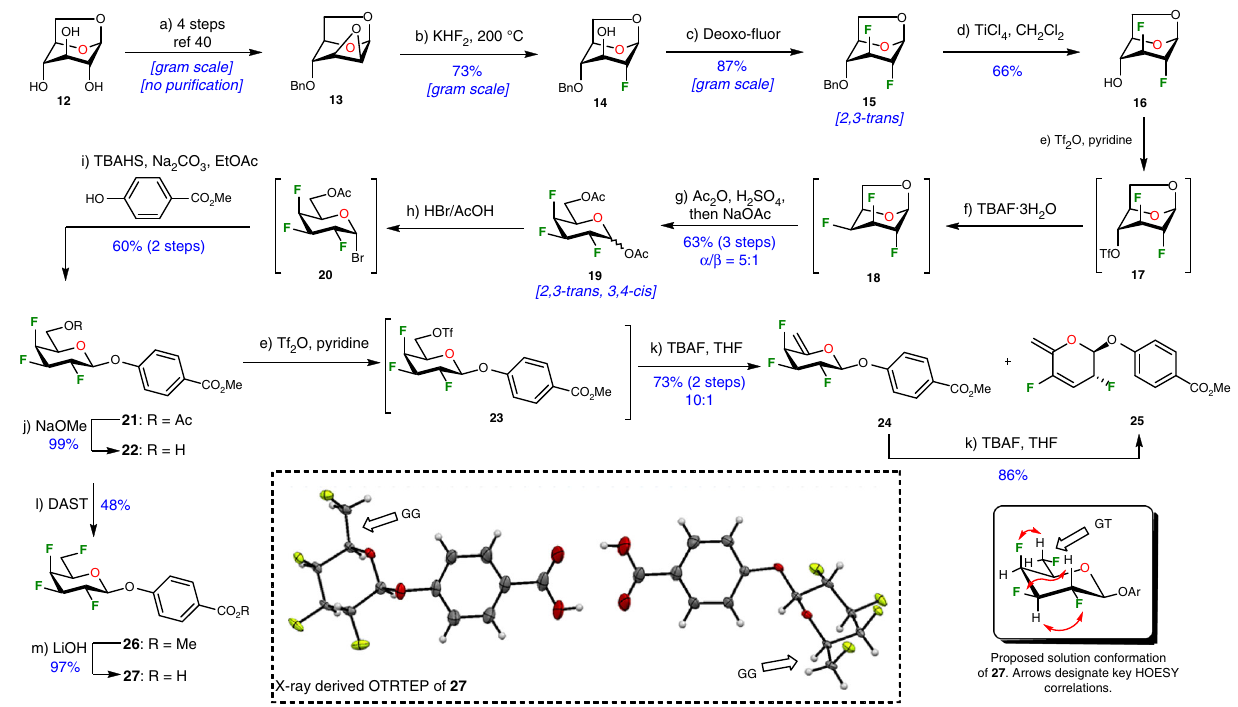
Fig. 2 Stereoselective synthesis of 2,3,4,6-tetradeoxy-2,3,4,6-tetra fl uorogalactopyranoside 27 from levoglucosan 12 . Reagents and conditions: (a) ref 40 ; (b) KHF 2 (7.0 equiv), ethylene glycol, 200 °C, 2.5 h, 73%; (c) Deoxo-Fluor (2.0 equiv), THF, microwave irradiation, 100 °C, 1.5 h, 87%; (d) TiCl 4 (1.1 equiv), CH 2 Cl 2 , 0 °C, 0.5 h, 66%; (e) Tf 2 O (2.0 equiv), pyridine (3.0 equiv), 0 °C, 0.2 h; (f) TBAF·3H 2 O (1.5 equiv), CH 2 Cl 2 , rt, 15 h; (g) Ac 2 O (30 equiv), H 2 SO 4 (10 equiv), 0 °C to rt, 18 h, then NaOAc (20 equiv), rt, 0.3 h, 63% over 3 steps, α / β = 5:1; (h) 33% HBr in AcOH, CH 2 Cl 2 , rt, 66 h; (i) methyl p - hydroxybenzoate (3.0 equiv), TBAHS (1.0 equiv), EtOAc, 1 M Na 2 CO 3 , rt, 18 h; 60% over 2 steps; (j) 1 M NaOMe, MeOH, rt, 1 h, 99%; (k) 1 M TBAF in THF (18 equiv), rt, 1 h (for 24 ), 3 days (for 25 ), 73% over 2 steps for 24 , 86% for 25 ; (l) DAST (3.0 equiv), 2,4,6-collidine (6.0 equiv), CH 2 Cl 2 , microwave irradiation, 100 °C, 1 h, 96%, 26 / 24 = 1:1; (m) 1 M LiOH (3.5 equiv), H 2 O/MeOH/THF (2:3:5), 97%. Ac 2 O acetic anhydride, DAST diethylaminosulfur tri fl uoride, Deoxo-Fluor bis (2-methoxyethyl)aminosulfur tri fl uoride, TBAF tetrabutylammonium fl uoride, TBAHS tetrabutylammonium hydrogen sulfate, Tf 2 O tri fl uoromethanesulfonic anhydride. ORTEP diagram of the molecular structure of 27 showing 50% thermal ellipsoid probability, carbon (gray), oxygen (red), fl uorine (light green), hydrogen